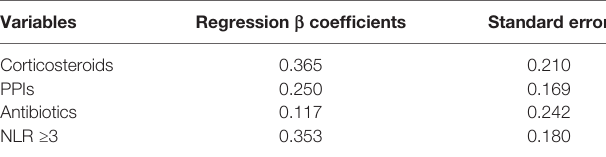
TABLE 1 | Baseline patient characteristics. TABLE 2 | Regression b coef fi cients for overall